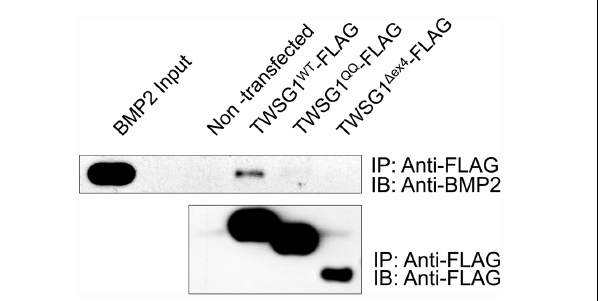
FIGURE 3 | Immunoprecipitation indicates that glycosylation and exon 4 are necessary for BMP binding. Immunoprecipitation (IP) was performed with anti-FLAG and immunoblots (IB) were probed with either anti BMP2 (top) or anti-FLAG (bottom); BMP2 immunoprecipitates with wild type but not glycosylation defectiveTWSG1 QQ or exon 4-deletedTWSG1 Δ ex4